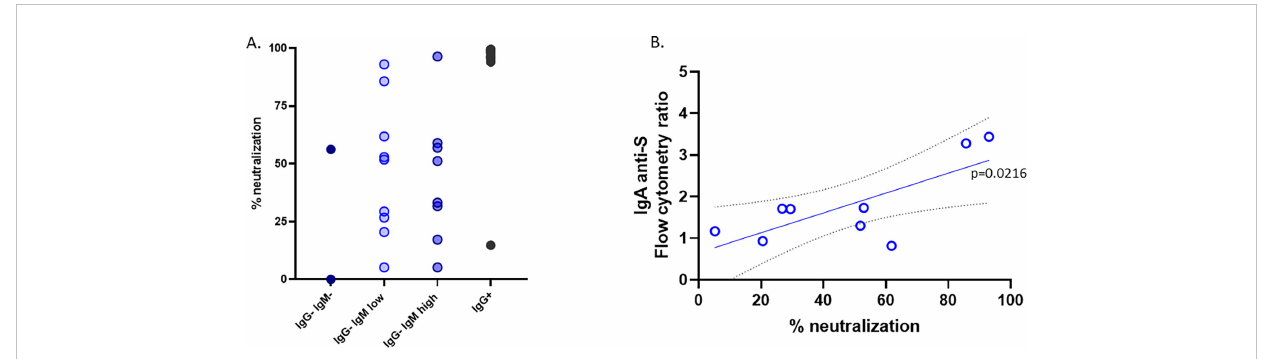
FIGURE 4 Neutralization. (A) The neutralization assay was carried out with the pseudotyped virus as described in the Material and methods . (B) Group IgG − IgM low showed a signi fi cant correlation between the neutralizing activity and the levels of IgA anti-S in the